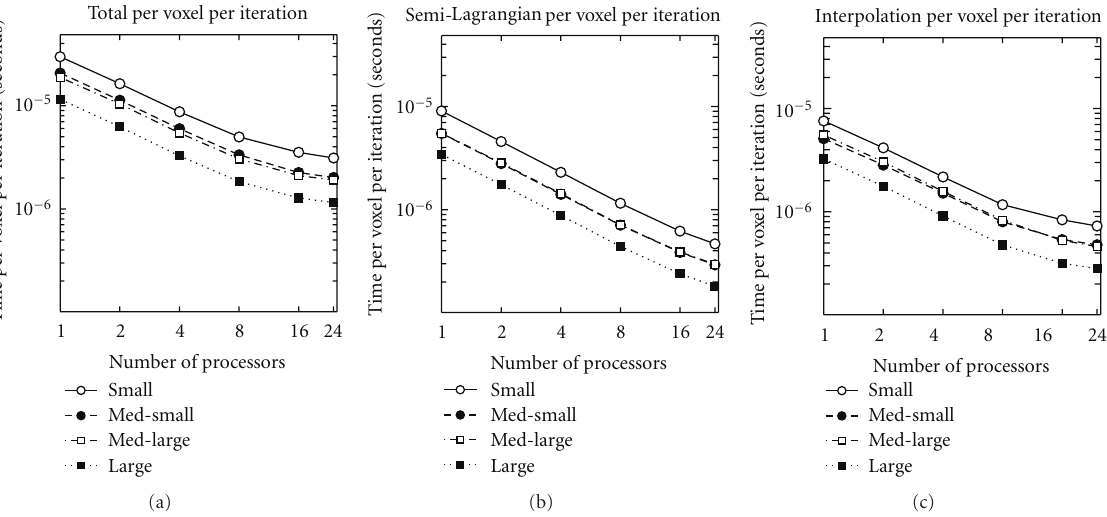
Figure 4: Time spent on computations, per image voxel per gradient descent iteration, for the four patients examined, plotted on a log-log axis. (a) Total time, (b) time in semi-Lagrangian advection, and (c) time in image interpolation. Note that in (a) small takes the longest, followed by med-small, med-large, and large. In (b) (for all processors) and (c) (from 1 to 8 processors), the order of the middle two is